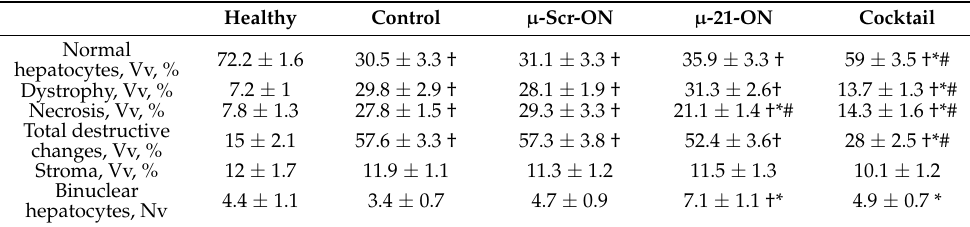
Table 1. Morphological changes in the liver tissue of healthy mice and mice with RLS 40 lymphosar- coma without treatment (Control) and after anti-miRNA-ON